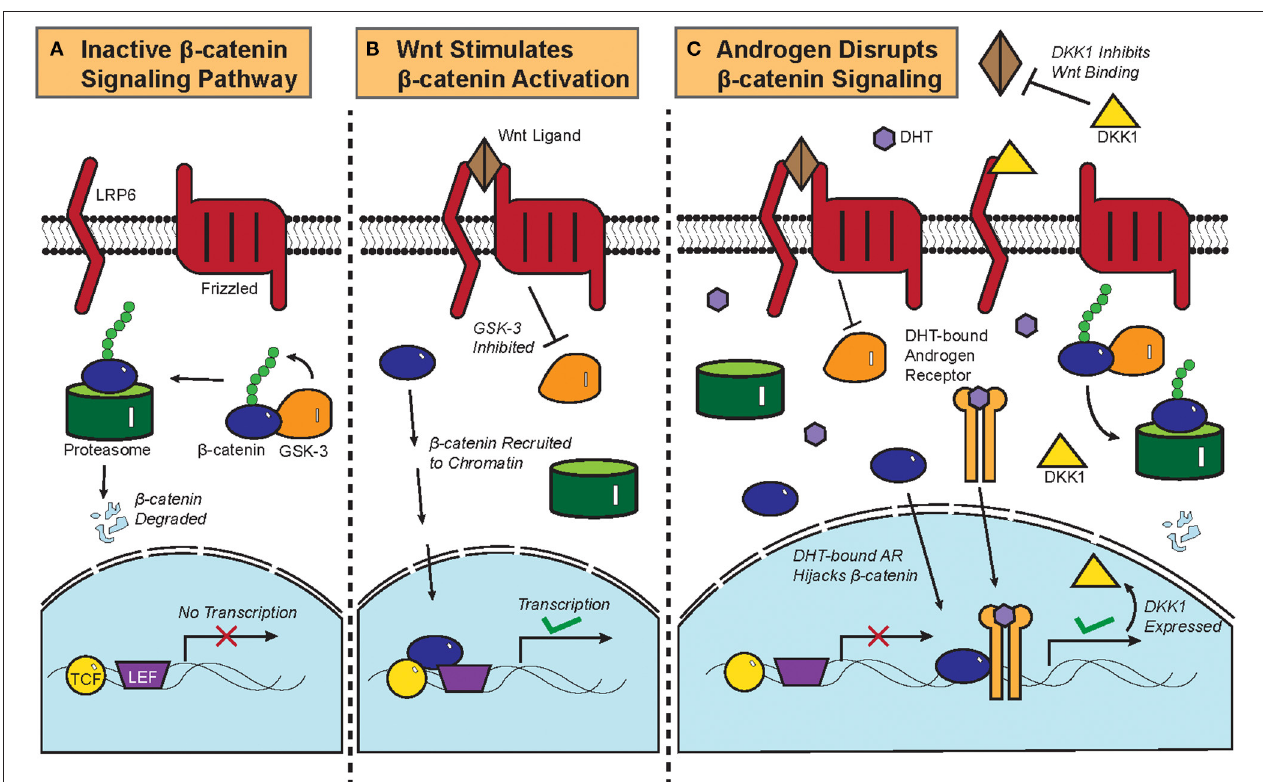
FIGURE 2 | Biochemistry of the Wnt/ β -catenin signaling pathway and its crosstalk with androgen. (A) Constitutive phosphorylation of β -catenin by glycogen synthase kinase 3B (GSK-3B) and subsequent proteasomal degradation of β -catenin in the absence of Wnt ligand. (B) Binding of Wnt ligand to Frizzled and Low-Density Lipoprotein-Related Protein (LRP) and the resultant inactivation of GSK-3B and its phosphorylation of β -catenin, which is then translocated to the nucleus to initiate the transcription of target genes. (C) DHT-activated AR can recruit β -catenin as a coactivator to stimulate the expression of DKK1, a competitive antagonist of the